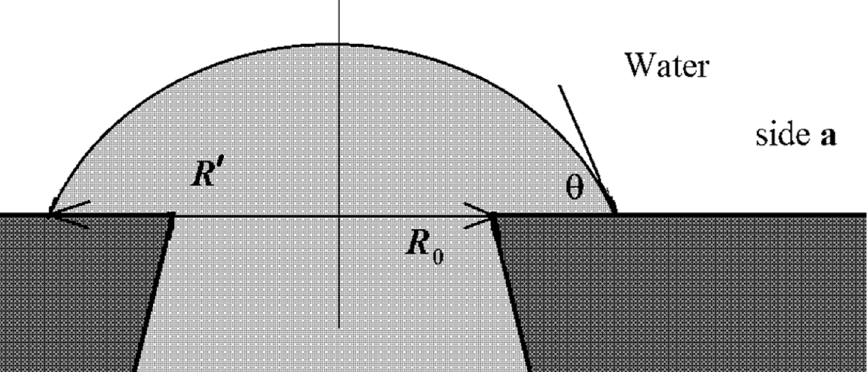
Figure 8. Scheme of the interaction of the water–insoluble organic liquid with the surface of the material and water on side a .